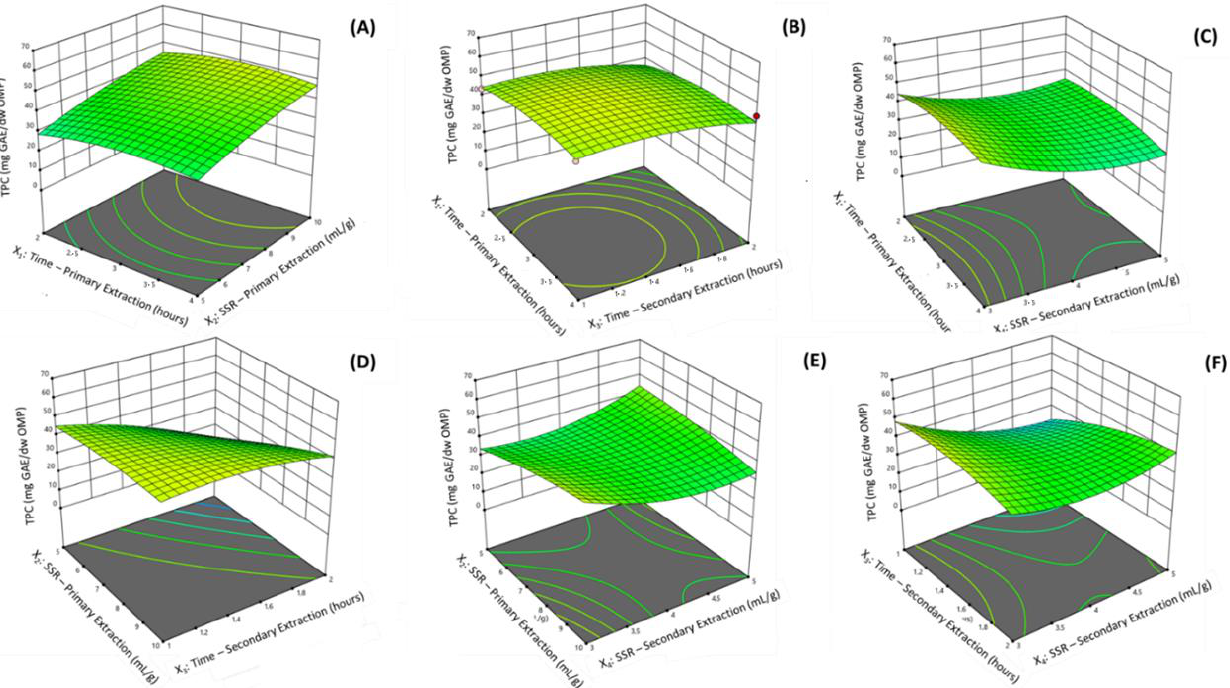
Figure 4. Response surface plots representing the effect of each process variable on the total phenolic content of the extracts obtained from OMP samples ( represent a design point). ( A ) X 1 : Time — Primary Extraction (hours) versus X 2 : solvent-to-sample ratio (SSR) — Primary Extraction (mL/g); ( B ) X 1 versus X 3 : Time — Secondary Extraction (hours); ( C ) X 1 versus X 4 : Time — Secondary Extraction (hours); ( D ) X 2 versus X 3 ; ( E ) X 3 versus X 4 ; ( F ) X 3 versus X 4 .